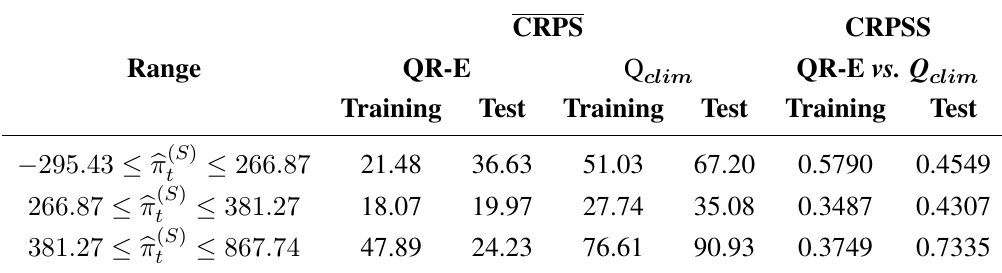
Table 4. The CRPS for the predictions from the QR-E model and the climatology quantiles, π ( S ) segmented according to . (cid:98) t CRPS CRPSS Range QR-E Q QR-E vs. Q clim clim Training Test Training Test Training Test − 295 . 43 ≤ π ( S ) (cid:98)